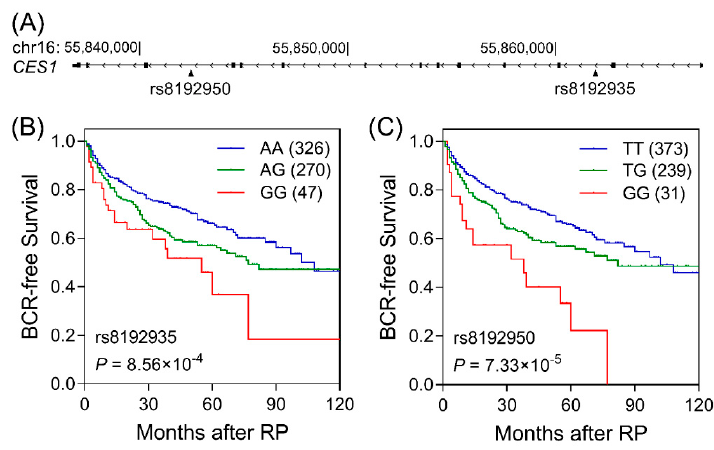
Figure 1. Association of CES1 rs8192935 and rs8192950 with biochemical recurrence (BCR)-free survival. ( A ) Schematic genomic structure of CES1 and the locations of rs8192935 and rs8192950. Kaplan–Meier curves of BCR-free survival for rs8192935 ( B ) and rs8192950 ( C ) genotypes. Values in brackets denote the number of patients. RP, radical